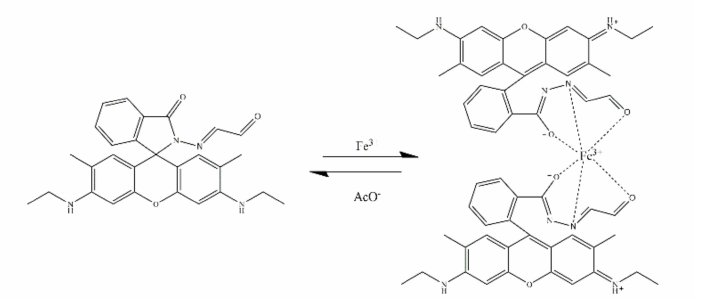
Figure 22. The proposed sensing mechanism of the prepared sensor L1 (Table 1, No. 28) to Fe 3+ [57]. Zhang M., et al. synthesized four rhodamine-based sensors through simple, high yield, and one-step Mannich reactions, and the acquired product M3 (Table 1, No. 29) exhibited a specific and sensitive response to Fe 3+ in acetonitrile/Tris-HCl buffer solution (3:7, v / v ; pH = 7.4) (Figure 23) [58]. The prepared Fe 3+ sensor was successfully applied in